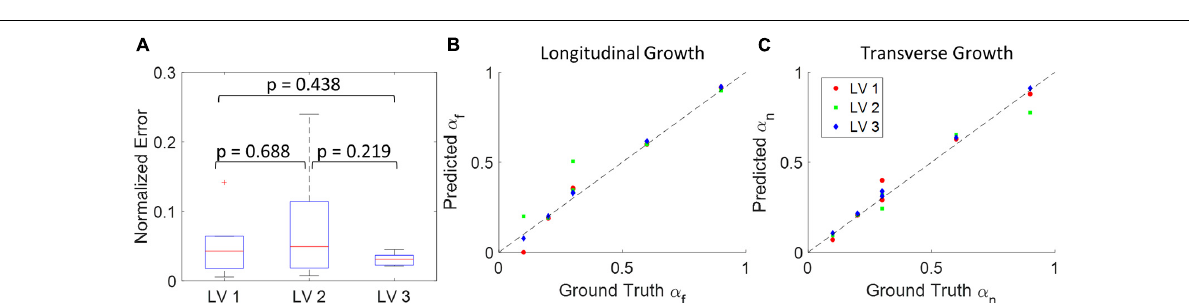
FIGURE 4 | DICE score heatmap results of the synthetic experiments. The top row shows the three LV geometries that were used in the synthetic experiments. The final prediction and ground truth are indicated in each heatmap as a blue star and red dot, respectively. For each LV geometry, two out of all six cases are shown. The middle row includes examples of growth that is largely dominated by longitudinal growth ( α f = 0 . 9, α n = 0 . 3) and the bottom shows examples of growth that is largely dominated by transverse growth ( α f = 0 . 1, α n = 0 . 3).